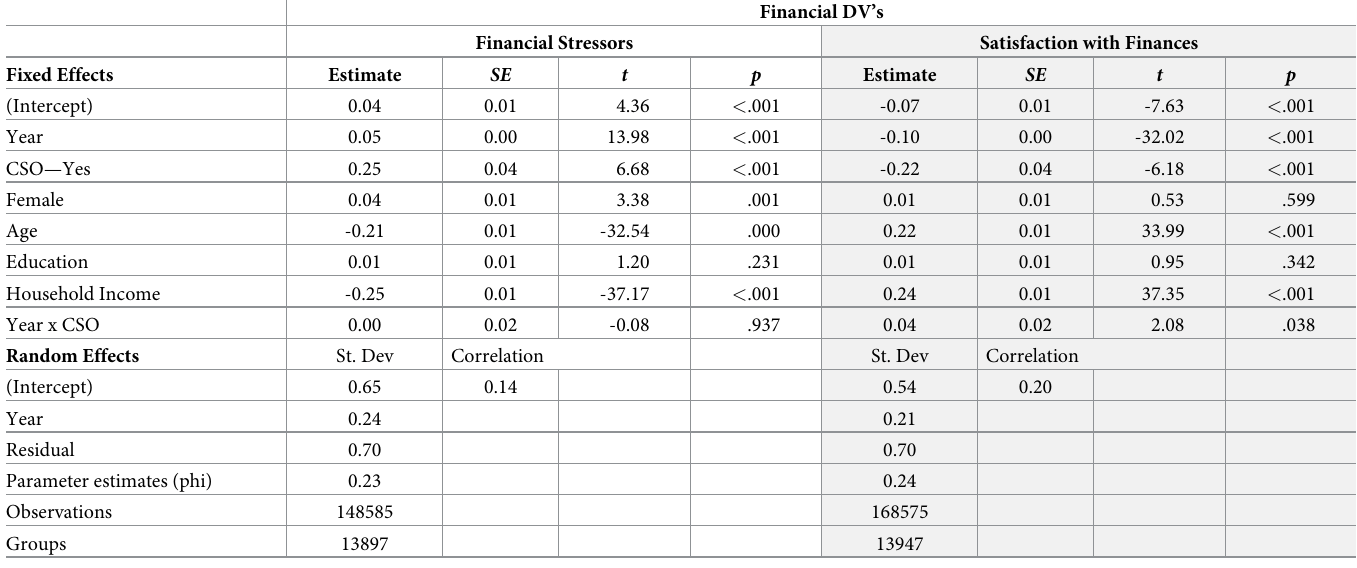
Table 5. Generalised linear mixed-effects model results for financial wellbeing